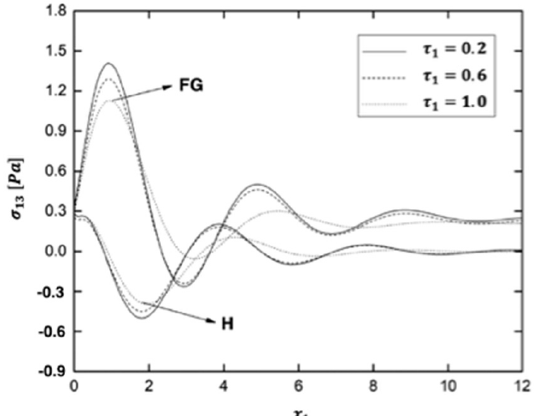
Figure 17. Variation of the thermal stress wave σ 13 along x 1 − axis in the functionally graded (FG) and homogeneous (H) anisotropic fiber-reinforced plates under different values of time characteristic of the laser pulse.